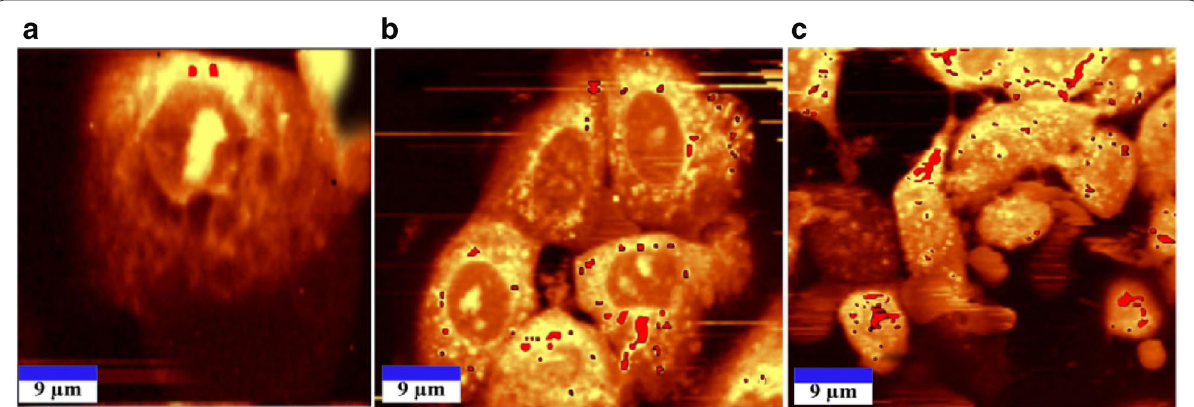
Fig. 13 Raman images of MCF‑7 cells incubated in paclitaxel. Integrated Raman intensities in the 2800–3000 cm − 1 region of the cell, marking paclitaxel as red spot. a 3 h; b 6 h; c 9 h incubation of cells in culture medium containing paclitaxel. Reprinted with permission from [120]. Copyright